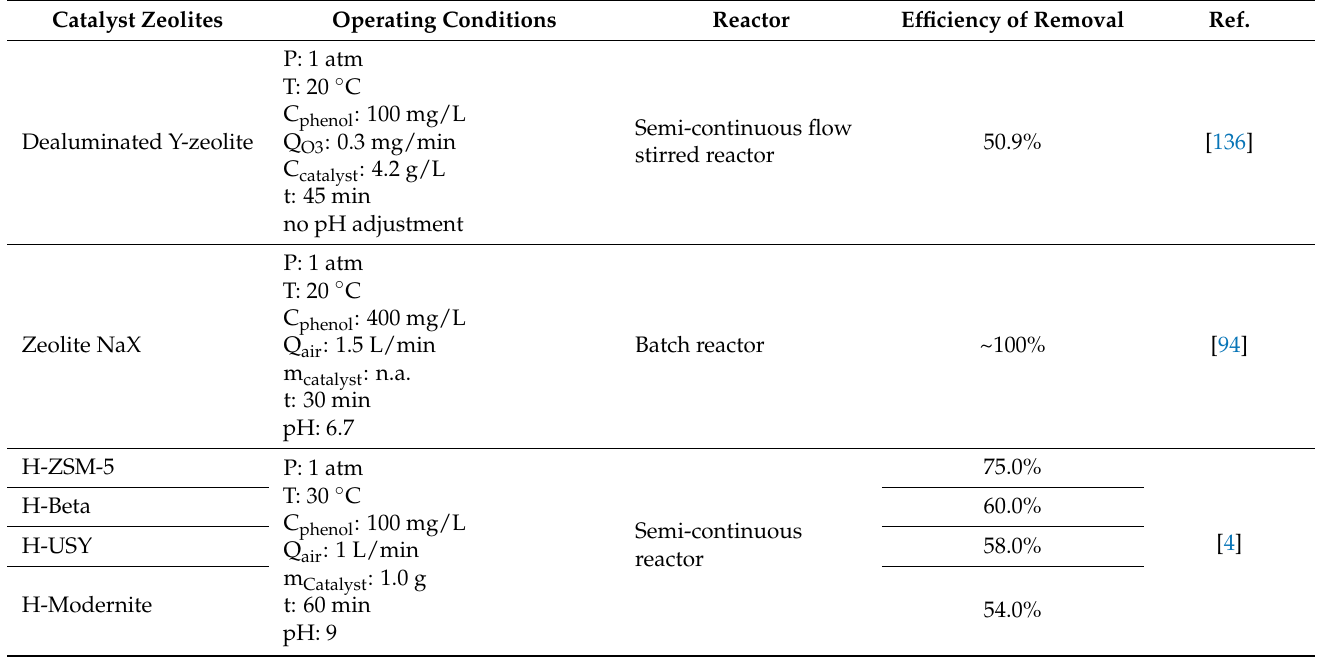
Table 14. The effectiveness comparison of zeolites-based catalyst for phenol removal via catalytic ozonation process. Catalyst Zeolites Operating Conditions Reactor Efficiency of Removal